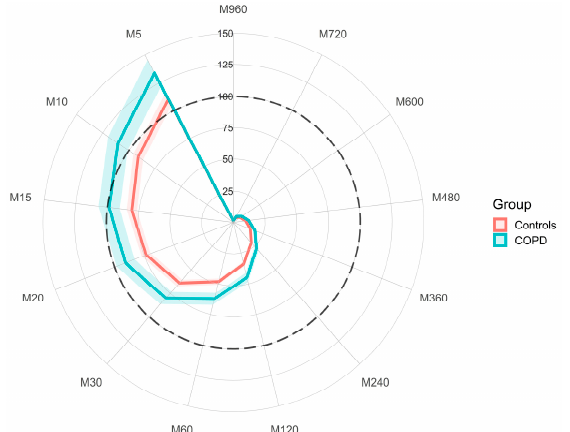
Figure 3. Radar plot representing the relative-intensity-adjusted MX metrics for both the control and COPD groups. The metrics indicate the intensity of the most active 5 min to 960 min of the day (e.g., M5 = most active 5 min per day) expressed as the percent of predicted maximum acceleration attained during the ISWT (black dotted line). The predicted maximum acceleration was derived by using the speed (km/h) from the last fully achieved stage during the incremental shuttle walk test and then using the equation as outlined by Dawkins et al. [27]. Coloured thick lines indicate the average value per group and the shaded portions either side of the lines indicates the standard error of the mean.